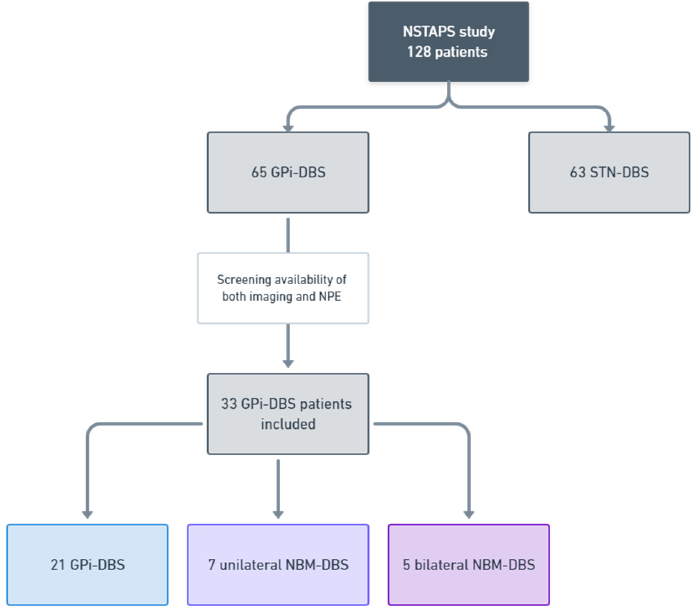
Figure 1. Data collection. Between January 2007 and March 2011, 128 patients participated in the NSTAPS study. Sixty-five patients were randomized to receive GPi-DBS. Since NBM is anatomically located ventral to the GPi, several GPi-treated patients appeared to have the distal contact of the DBS-electrode(s) positioned in NBM. The research database was screened for the concurrent presence of neuroimaging and neuropsychological evaluations (NPE), which were available for thirty-three GPi-DBS candidates. The positions of the DBS electrodes and active contacts were reviewed in these patients, which yielded three categories: GPi-DBS ( N = 11), unilateral NBM-DBS ( N = 7), and bilateral NBM-DBS ( N = 5). Abbreviations: NPE = neuropsychological evaluations.